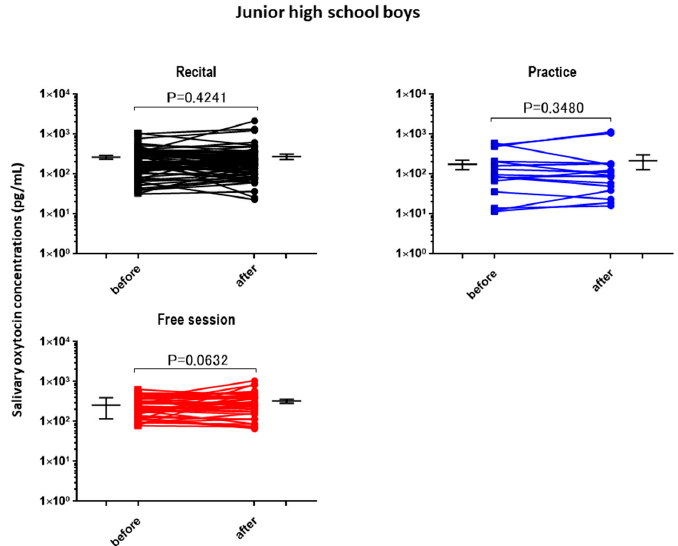
Figure 2. Changes in junior high school boys’ oxytocin levels before and after a single play session. Oxytocin levels are for the first (before) and second (after) salivary samples. Saliva was collected at each recital ( n = 61), practice ( n = 17), and free play ( n = 55) session. p values are for two-tailed Student’s t -tests.